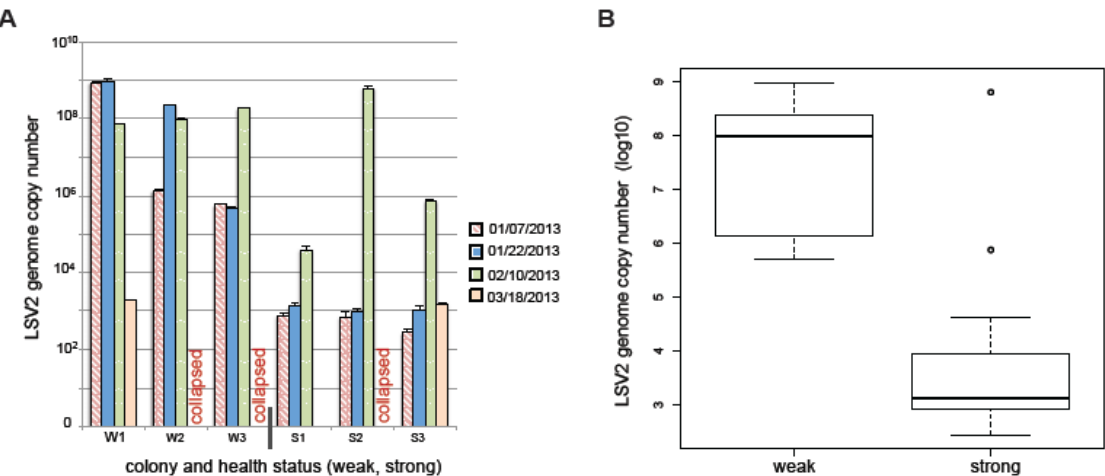
Figure 7. Lake Sinai virus 2 abundance trends with colony health. Honey bee colony health and pathogen prevalence and abundance ( n = 6) were monitored from January–March 2013. Honey bee colonies that were weak (<5 frames, n = 3) at the onset of the study are labeled W1, W2, and W3, and colonies that were strong (>9 frames, n = 3) at the onset of the study are labeled S1, S2, and S3. ( A ) Quantitative-PCR was used to determine the relative number of LSV2 genomes associated with each sample. Overall weak colonies had higher levels of LSV2 than strong colonies, as did colonies that died during the monitoring study (W2, W3, S2). Recovery of one colony that was weak at the onset of the study (W1) coincided with lower levels of LSV2. ( B ) The mean abundance of LSV2 was greater in weak colonies (log 10 = 7.55) as compared to strong colonies (log 10 = 3.19, Welch Two Sample t -test p = 8.89 × 10 − 5 ). In this small sample cohort weak colonies (<5 frames, n = 9 sampling events) had greater levels of pathogens relative to strong colonies (>9 frames, n = 11 sampling events) (Supplementary Figures S8 and